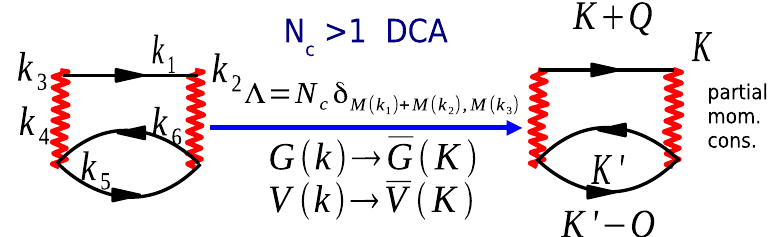
Figure 22. A second-order term in the self-energy of the Hubbard model obtained from the first functional derivative of the corresponding term in the generating functional Φ (Figure 21). When the DCA Laue function is used to describe momentum conservation at the internal vertices, the momenta collapse onto the cluster momenta and each lattice Green’s function and interaction is replaced by the corresponding coarse-grained